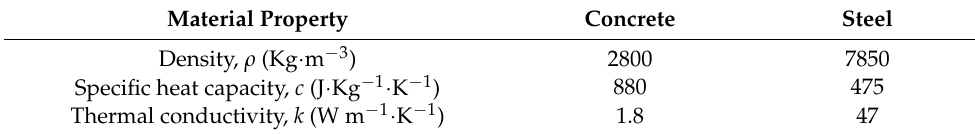
Table 1. Properties of concrete and steel.